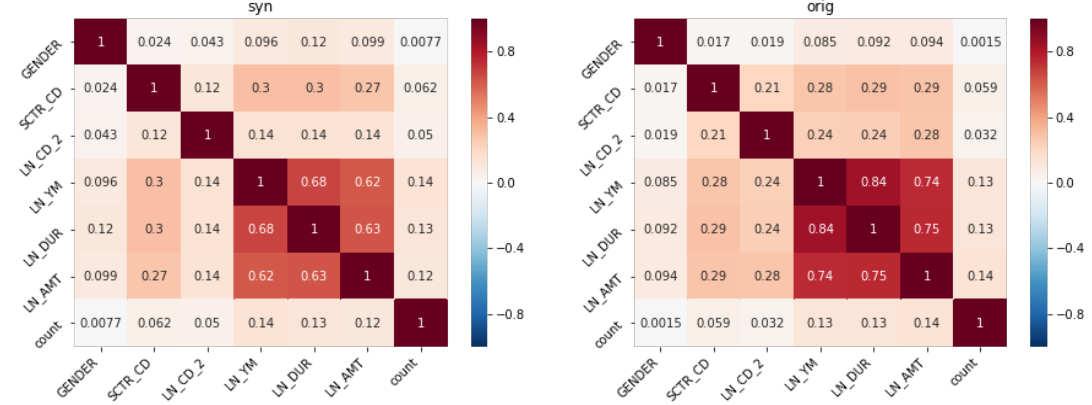
Figure 6. Normalized Mutual Information Matrix from Synthetic and Original dataset for car owners’ group with three loans.